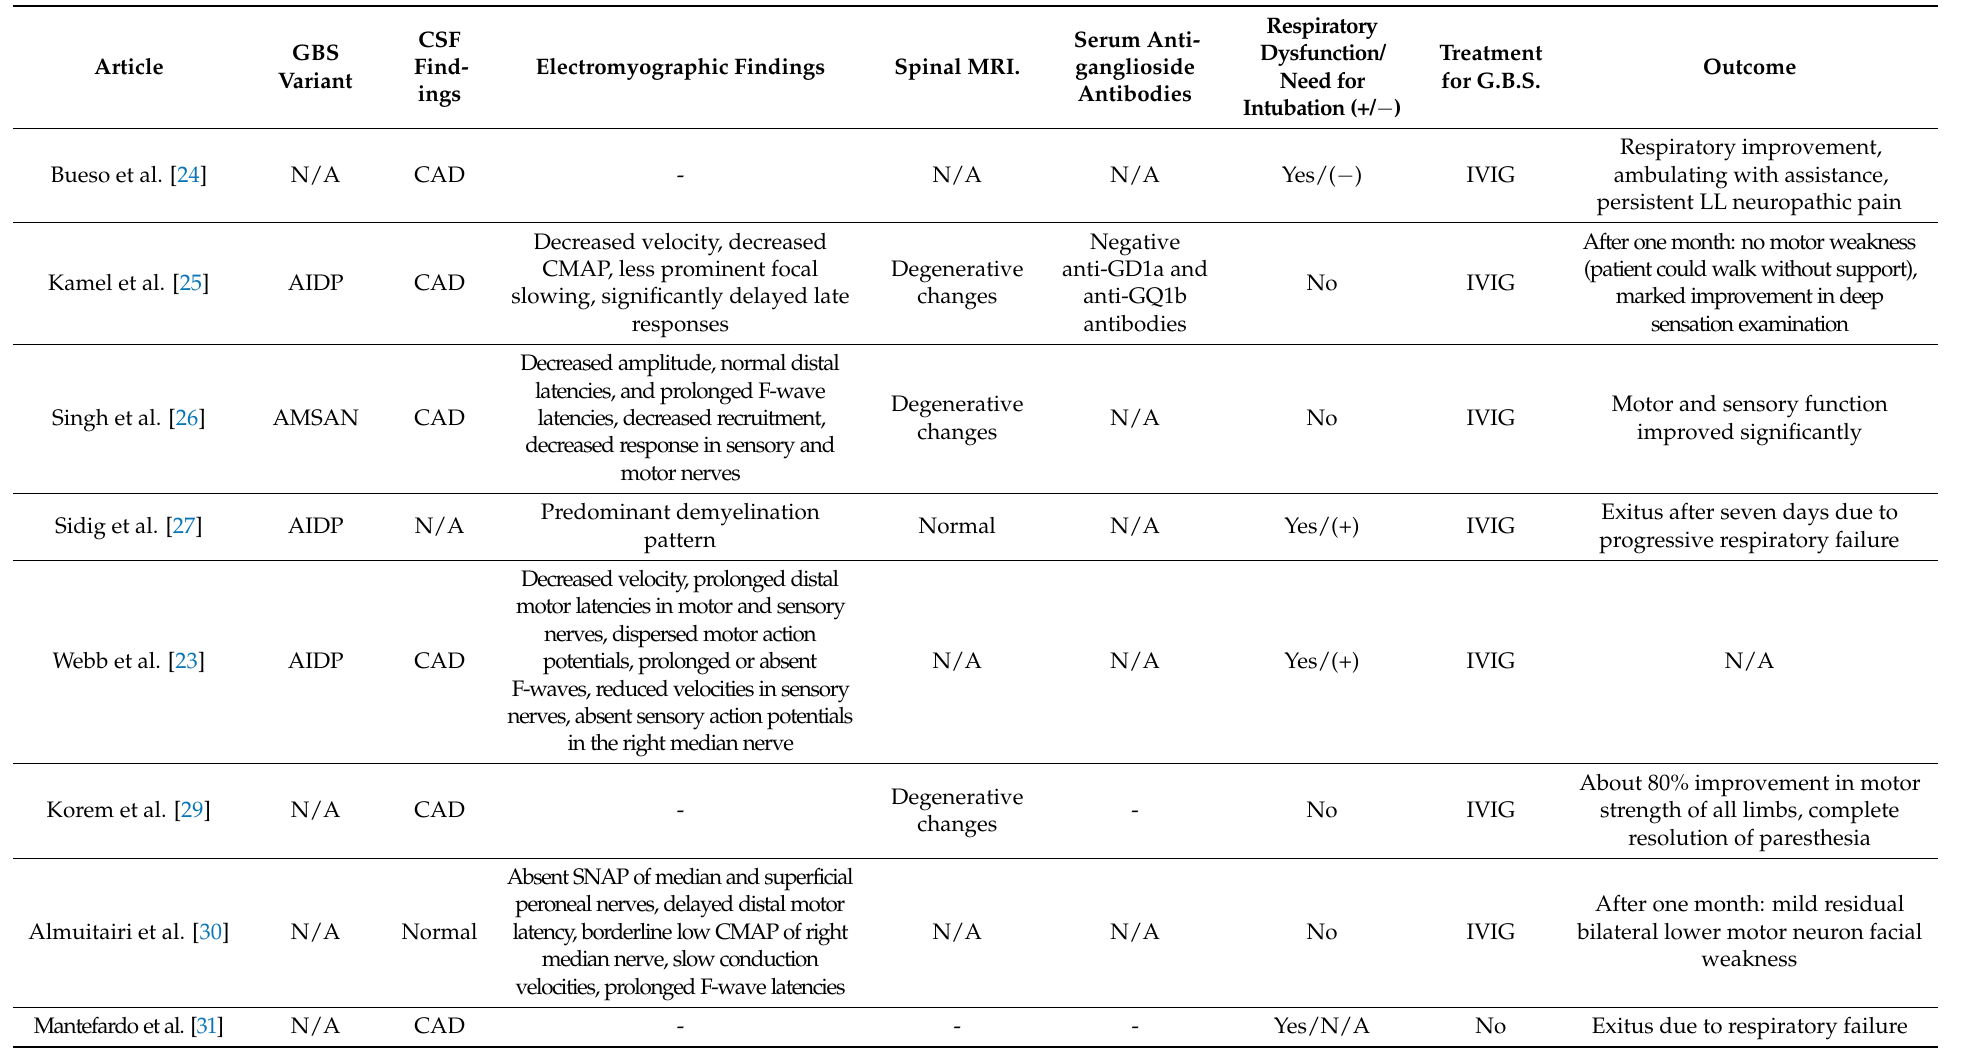
Table 5. Diagnosis, treatment, and outcome synopsis in